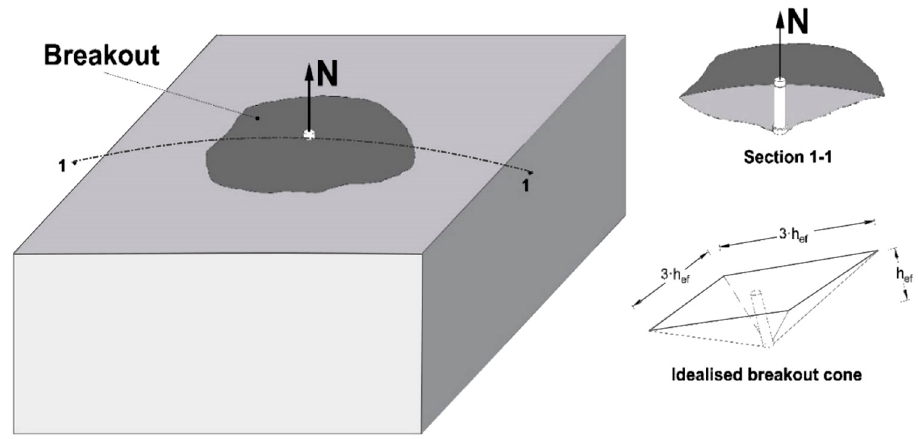
Figure 1. Sketch of concrete cone failure, and dimensions of the idealised cone.